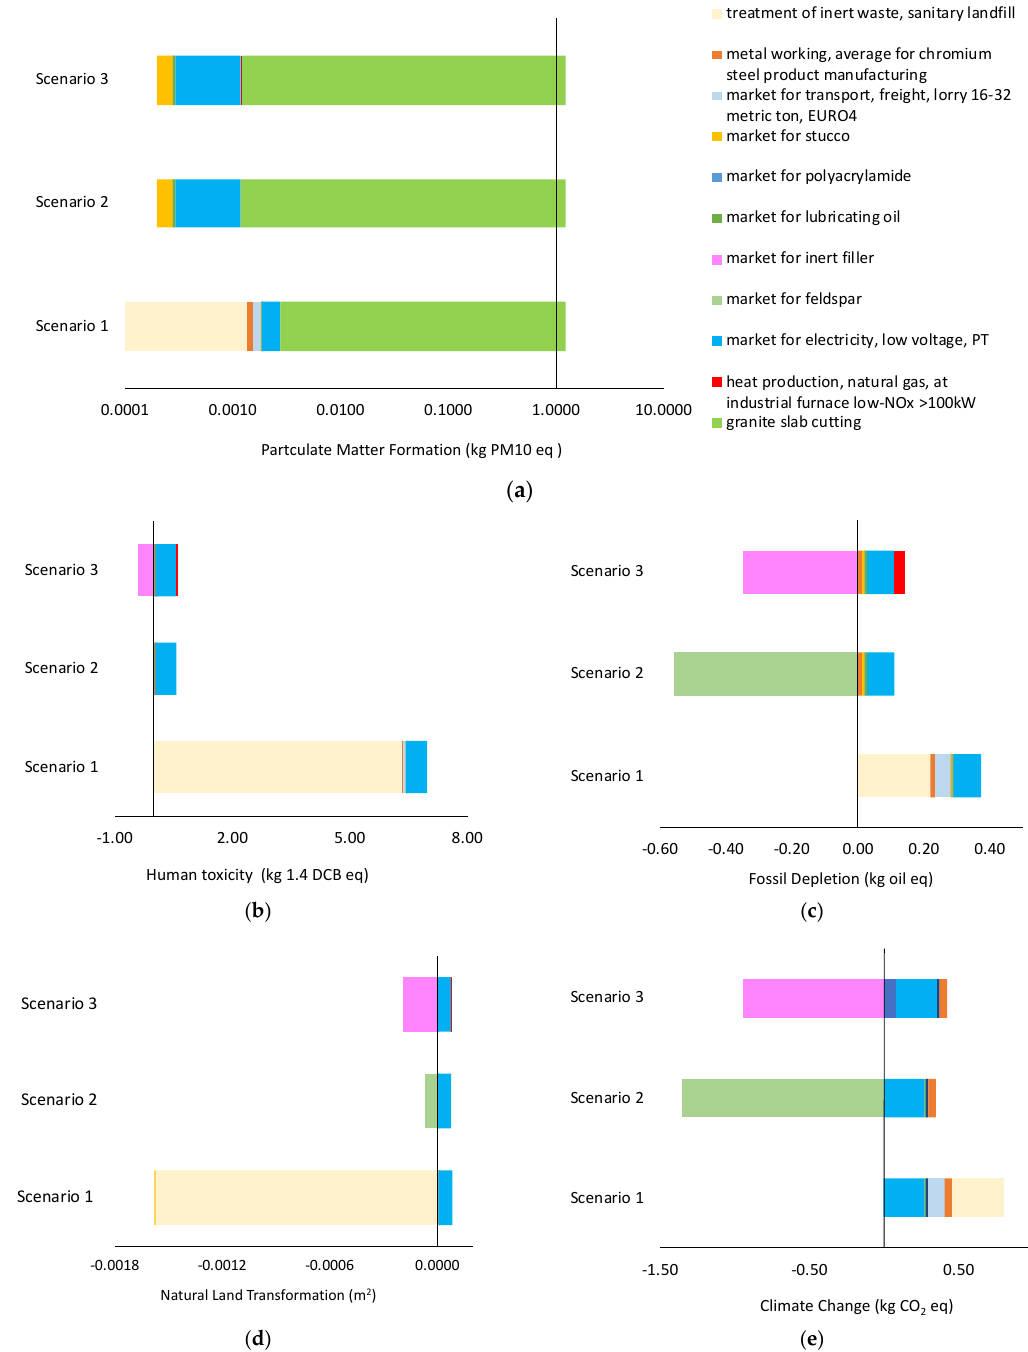
Figure 4. Contribution to ( a ) Particulate matter formation, ( b ) Human toxicity, ( c ) Fossil depletion, ( d ) Natural land transformation, and ( e ) Climate change according to ReCiPe2016 (Cut-o ff 0.1%).